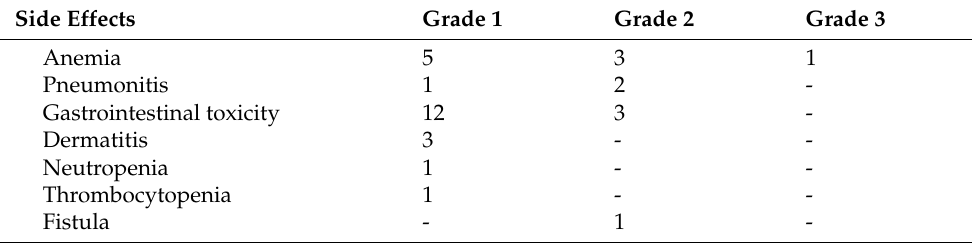
Table 3. Toxicities in mRCC patients from stereotactic radiotherapy.